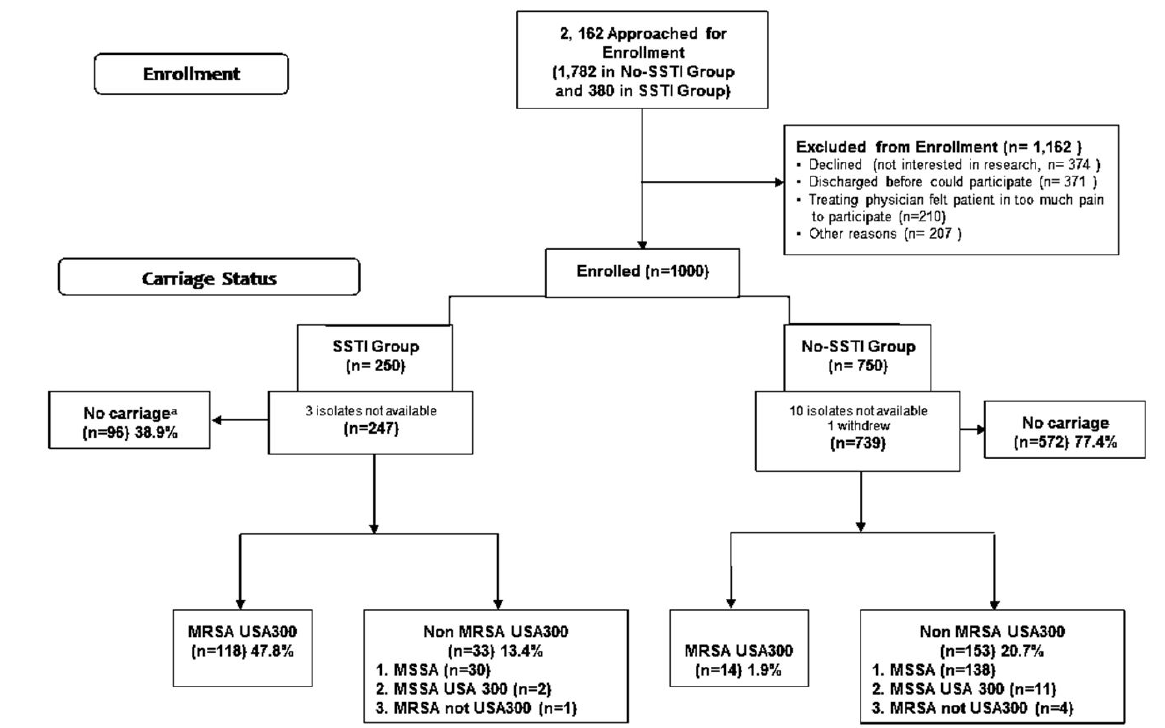
Figure 1. Staphylococcus aureus carriage enrollment flow diagram. a Definition for ‘No carriage’: No detection of S. aureus from SSTI wound culture or no detection of S. aureus from cultures obtained from nasal or axillary